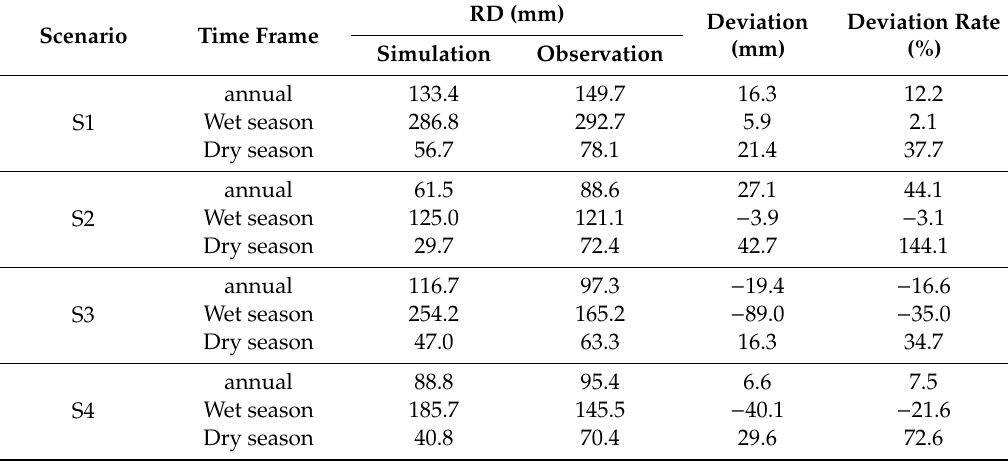
Figure 7. Simulated and observed monthly runoff under scenarios ( a ) S1, ( b ) S2, ( c ) S3, and ( d ) S4.